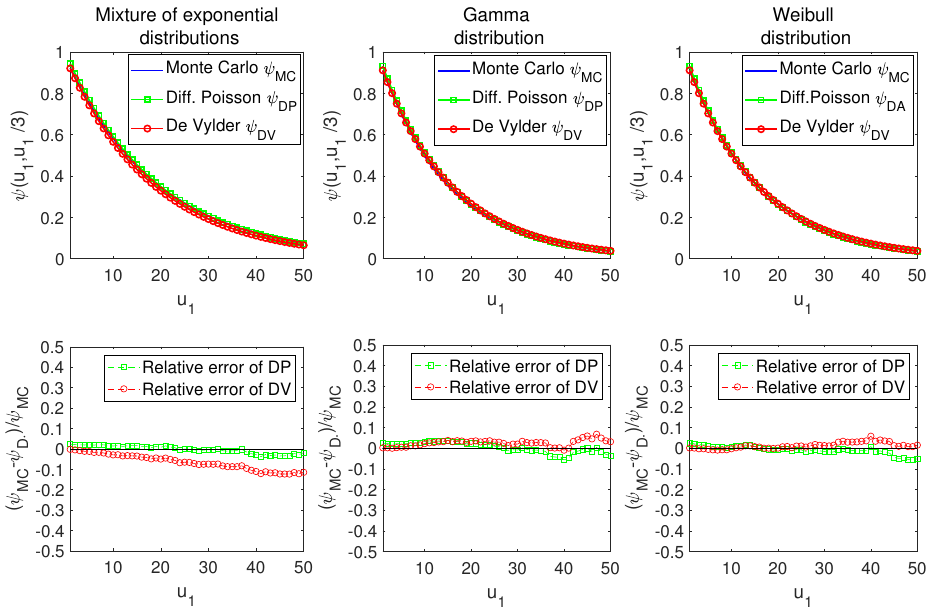
Figure 5. Ruin probabilities ( top panels) for the insurer–reinsurer model in the infinite-time horizon calculated using Monte Carlo (MC) simulations with the Poisson process with λ = 10, the diffusion approximation with the Poisson process (DP) and the De Vylder-type approximation (DV) for selected light-tailed distributions. Respective relative errors ( bottom panels) of the approximations. In the simulations the number of MC iterations is 10,000, parameters of claim distributions are given by Equations (18)–(20).